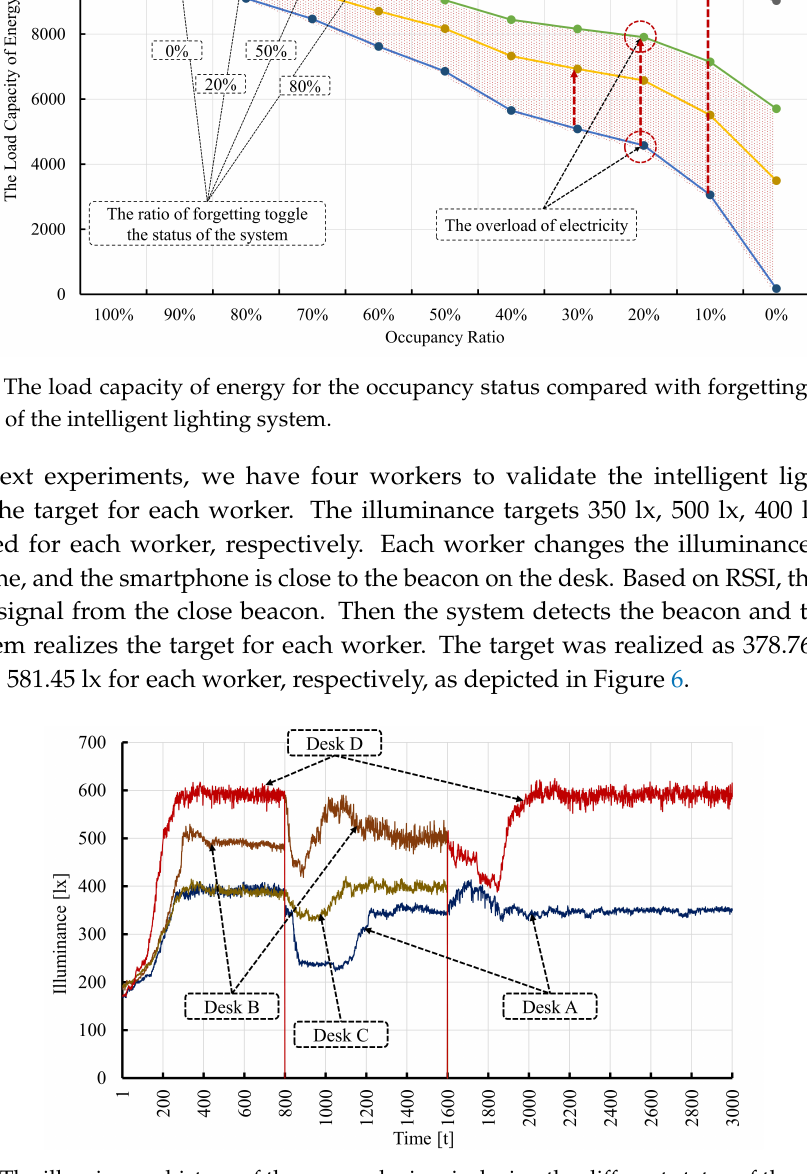
Figure 6. The illuminance history of the sensor devices is during the different status of the occupancy inside the